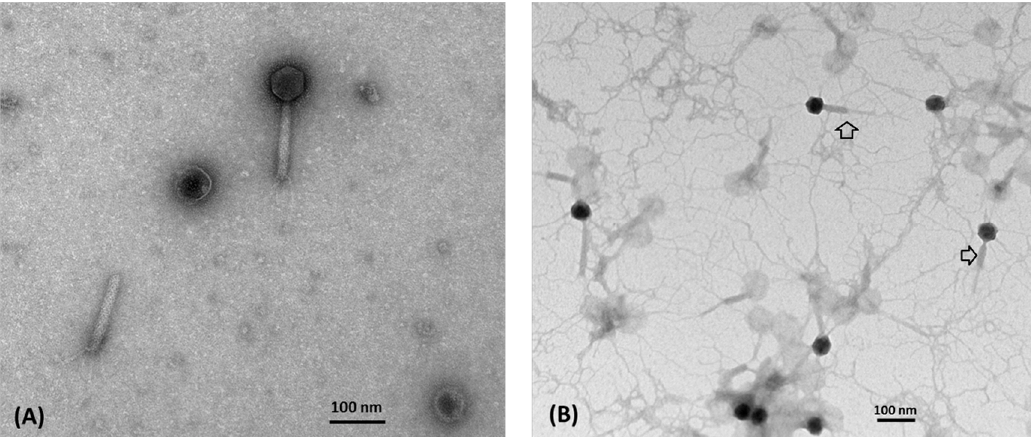
Figure 1. Morphology of Ahp2. Ahp2 was negatively stained with 2% uranyl acetate and examined under a transmission electron microscope. A total of 15 phage images were examined. Representative images show the phage particles with uncontracted ( A ) and contracted ( B ) tails (Arrow) Bar: 100 nm.